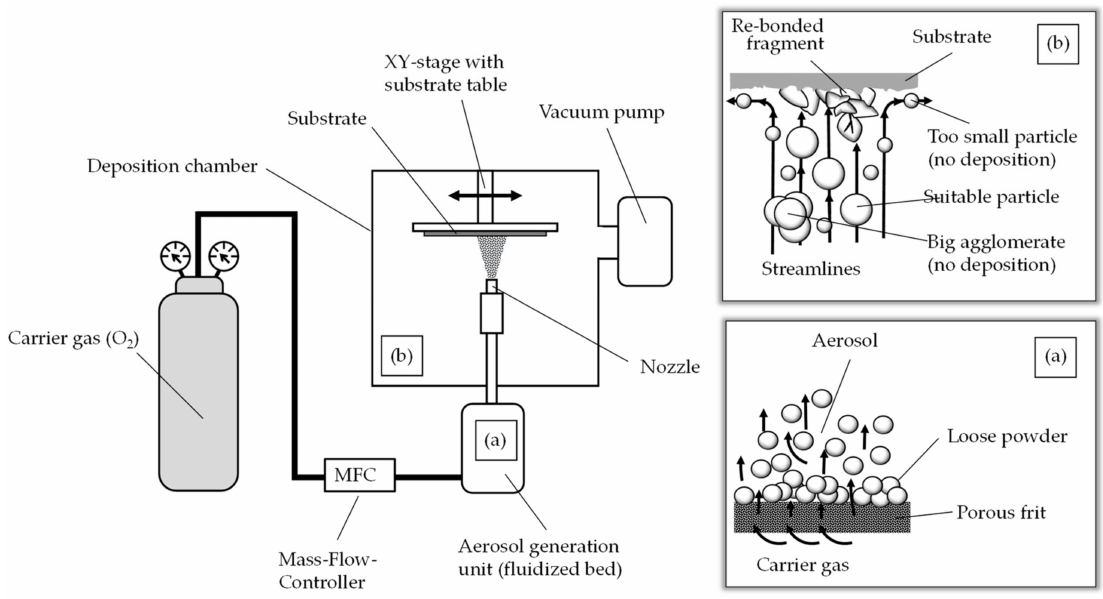
Figure 1. Schematic diagram of an aerosol deposition apparatus and the functional principle: ( a ) aerosol generation by fluidized bed; ( b ) film formation